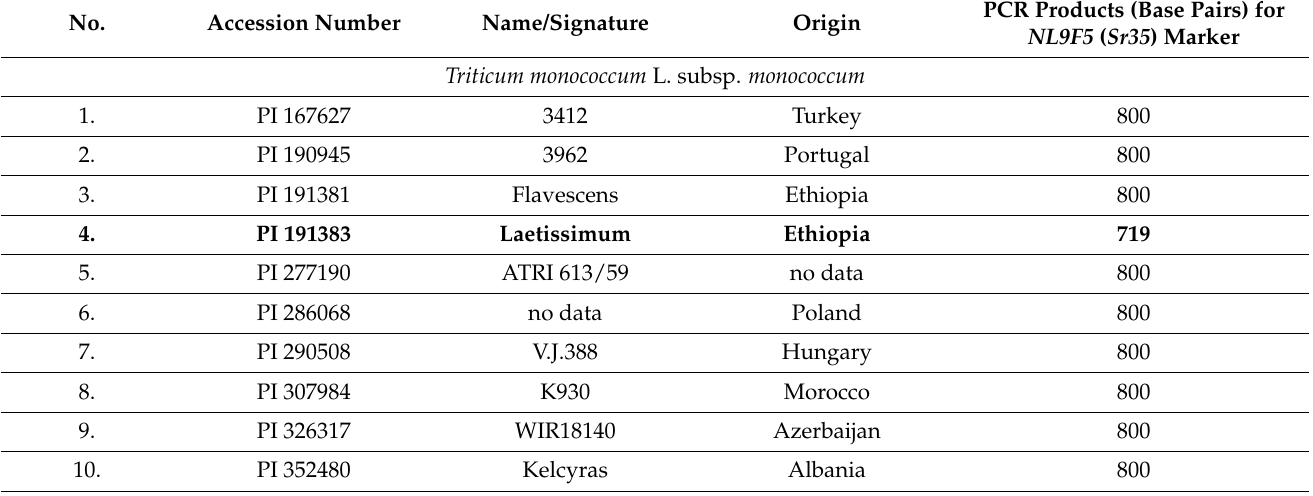
Table 1. Triticum monococcum and Secale cereale accessions screened with Sr22 and Sr35